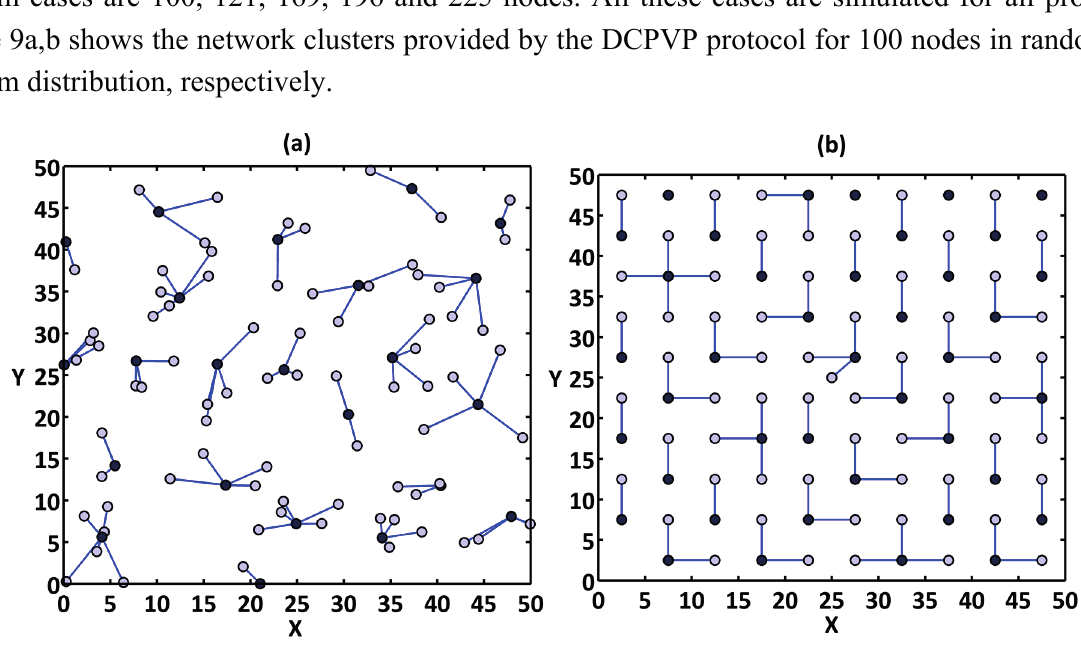
Figure 9. The network clusters for 100 nodes; ( a ) distributed randomly; ( b )